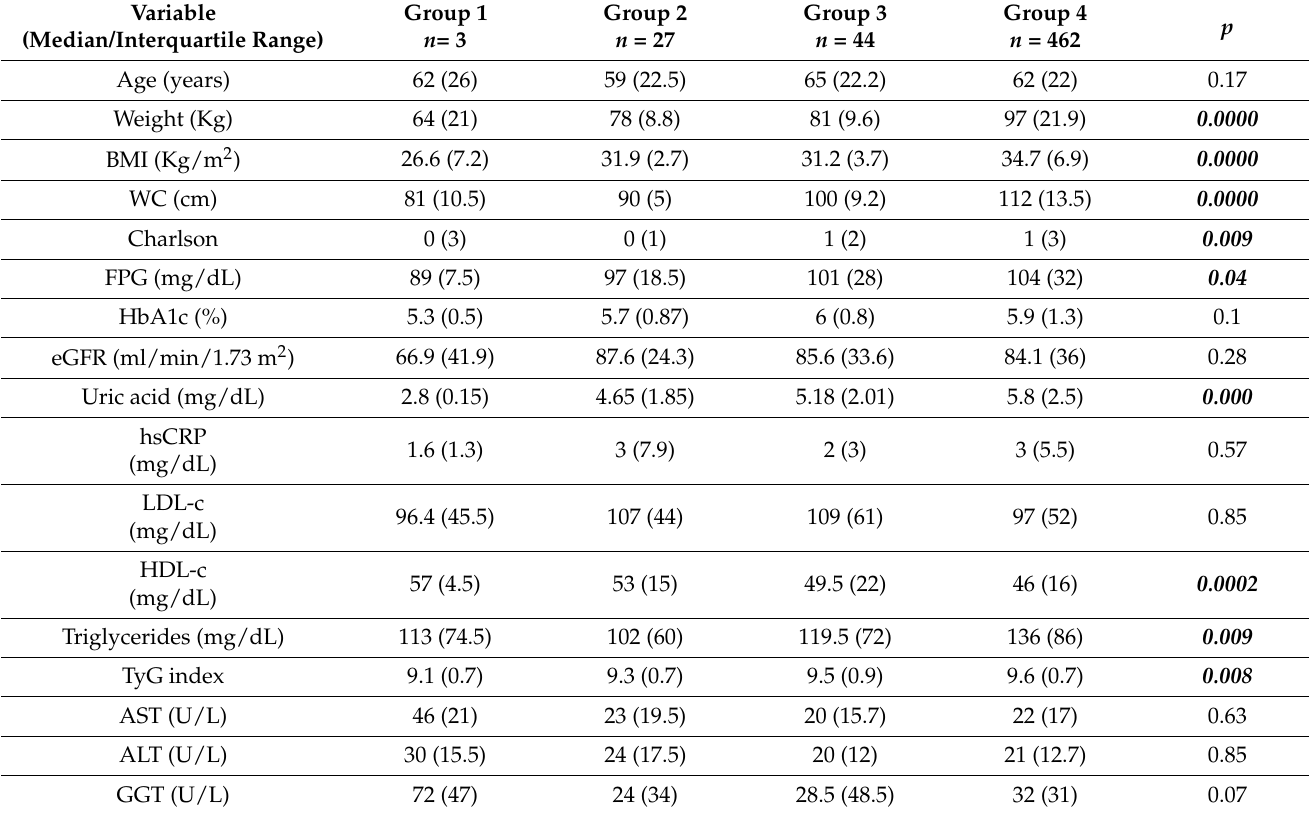
Table 2. Quantitative Variables by